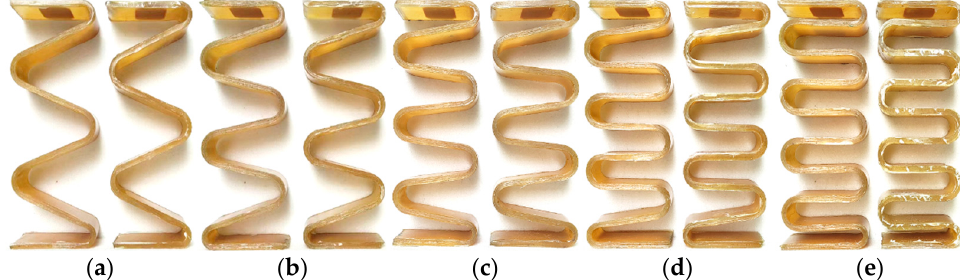
Figure 3. Schematic diagram of the GFRP wave spring specimens, ( a ) T = 2, ( b ) T = 2.5, ( c ) T = 3, ( d ) T = 3.5, ( e ) T = 4.